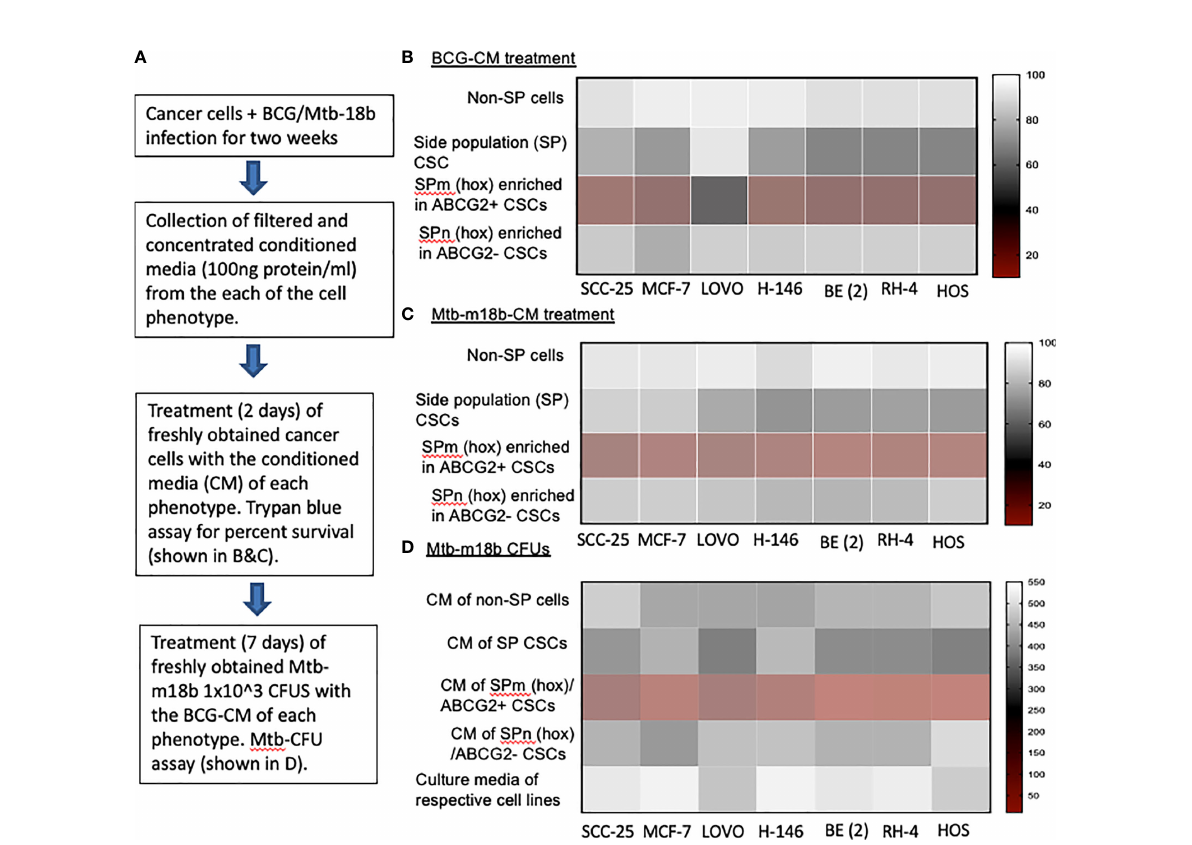
FIGURE 1 The tumor stemness phenotype of SPm (hox)/ABCG2+ CSCs exhibits BCG- or Mtb-m18b – mediated bystander apoptosis and anti-microbial activity. (A) Experimental plan. To investigate the niche defense potential of each phenotype, we treated the conditioned media (CM) of infected phenotype with the untreated corresponding phenotype. (B, C) Marked bystander cell death is seen in the SPm (hox) cells enriched in EpCAM+/ABCG2+ CSCs group. These SPm (hox) cells exhibit tumor stemness (TS) phenotype (5 – 7). (D) The CM of SPm(hox)+/ABCG2+CSCs exhibit anti-microbial activity against Mtb-m18b. The vertical bar represents percent of cell survival in (B, D) , and number of Mtb-m18b CFUs in (D) . Experiments were repeated 4 times, and the results were compared between SPm (hox) and SPn (hox) by student t tests. Results are given in the